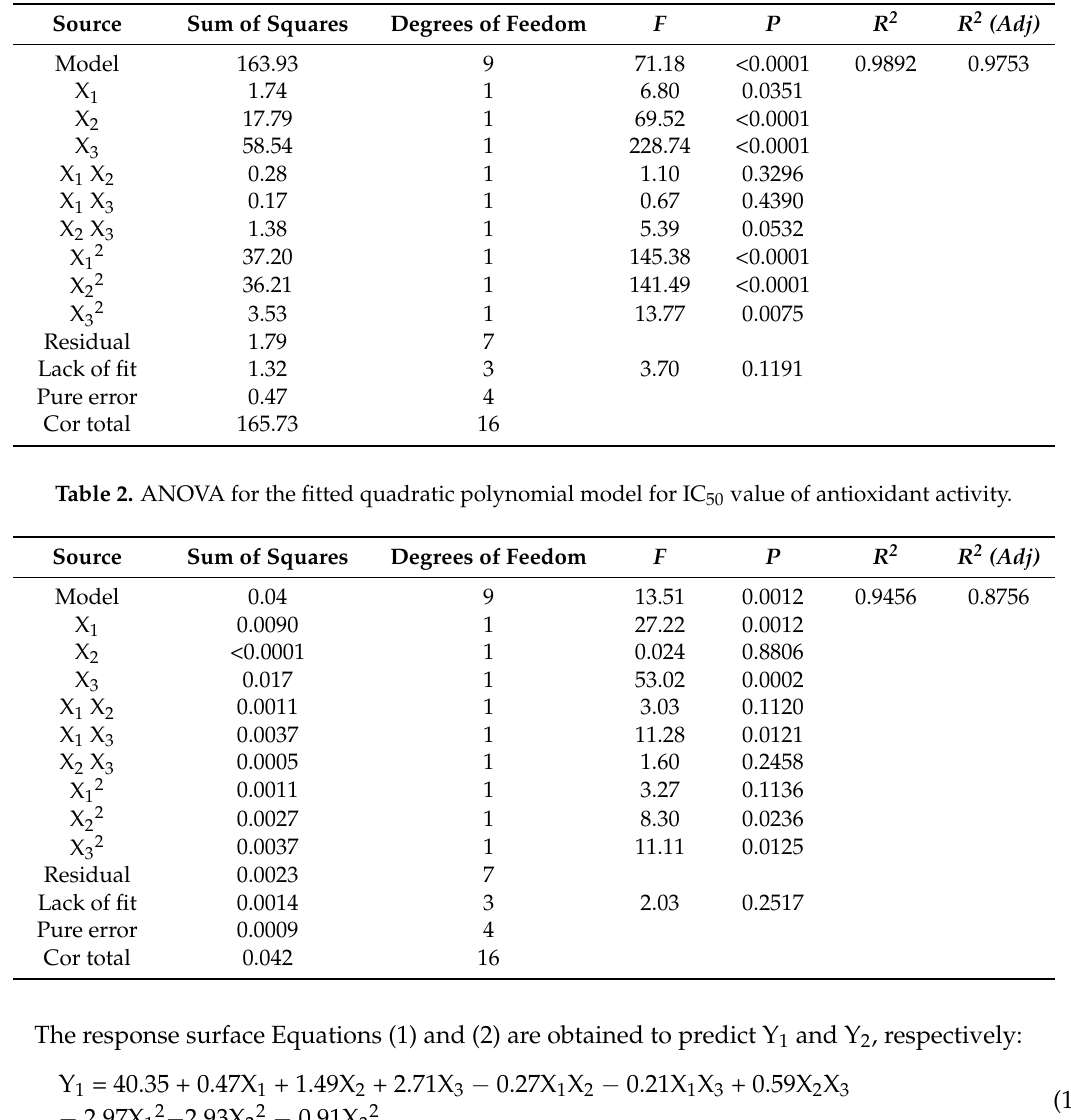
Table 1. ANOVA for the fitted quadratic polynomial model for major flavonol content.